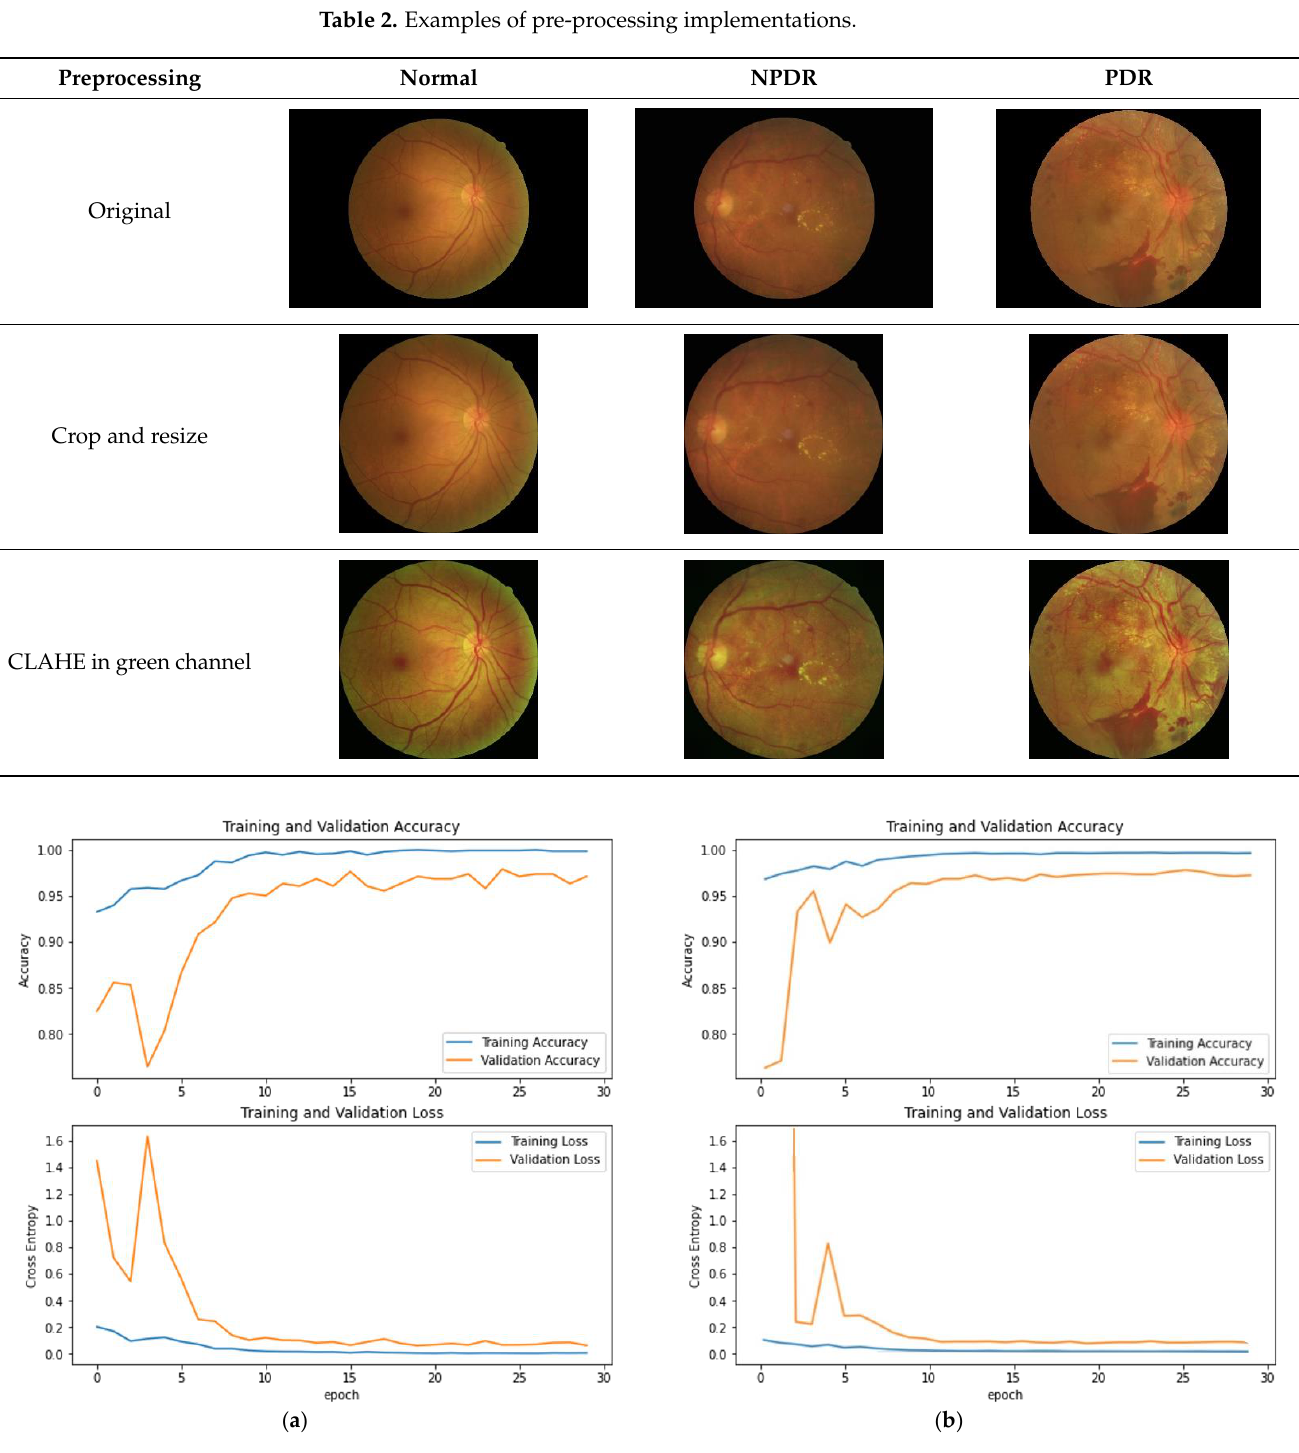
Table 3. The confusion matrix of DenseNet121. DenseNet121 Model